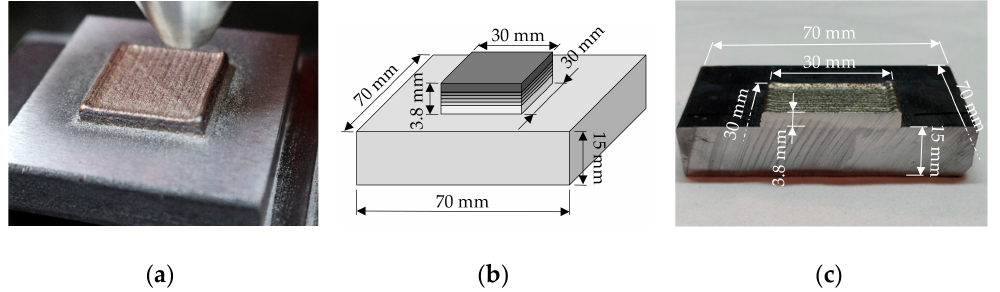
Figure 4. Dimensions of the manufactured samples: ( a ) functionally graded material (FGM) sample during the L-DED process, ( b ) schematic illustration of the fabricated FGM sample with dimensions, and ( c ) fabricated FGM sample with dimensions.